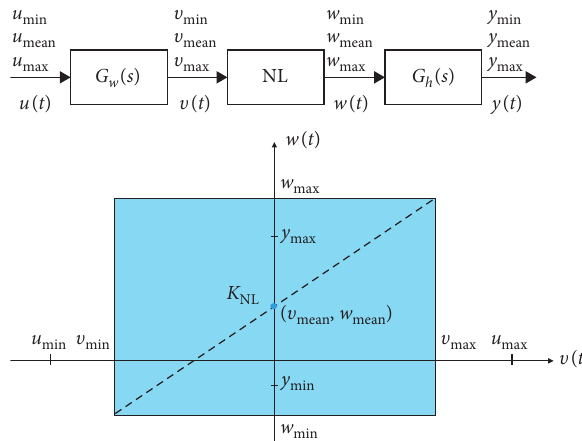
Figure 2: Search space for nonlinear static function in a Wie- ner–Hammerstein model.